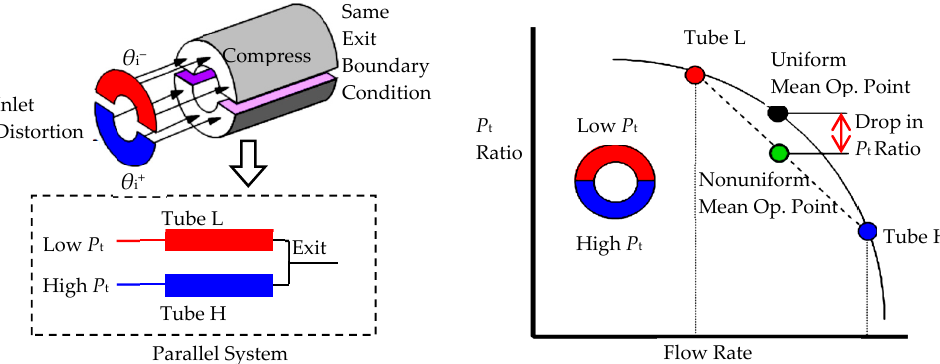
Figure 1. Parallel compressor theory concept [17].